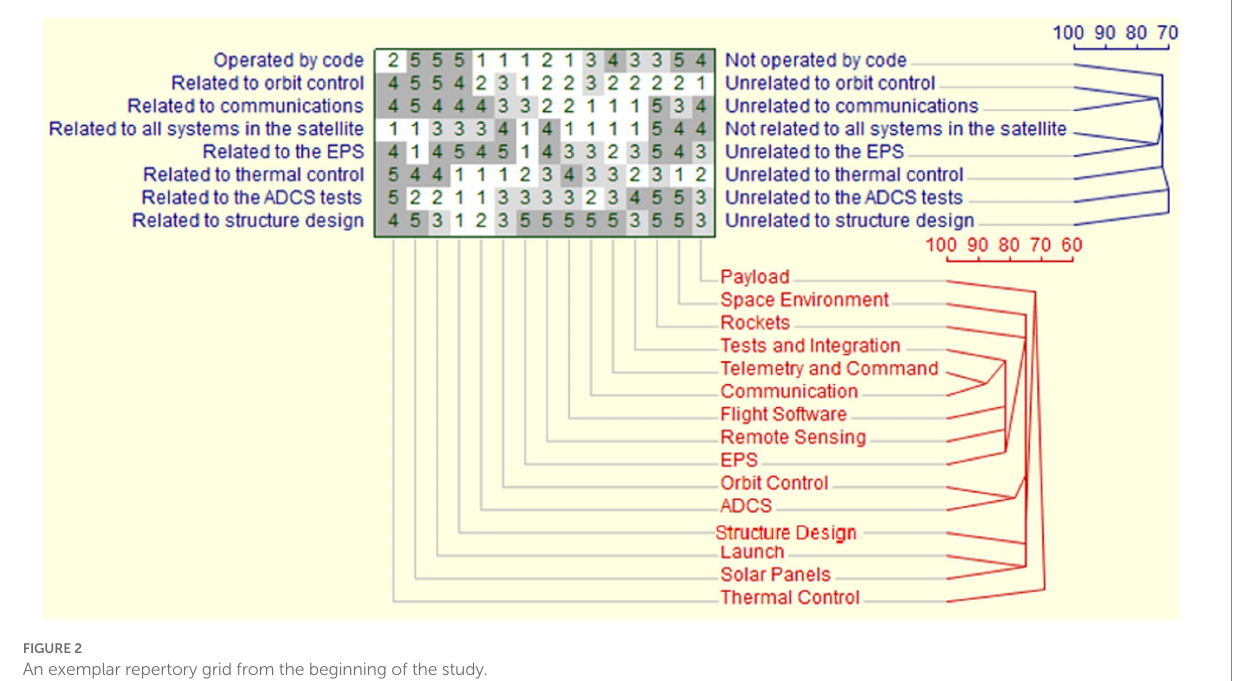
FIGURE 2 An exemplar repertory grid from the beginning of the study.